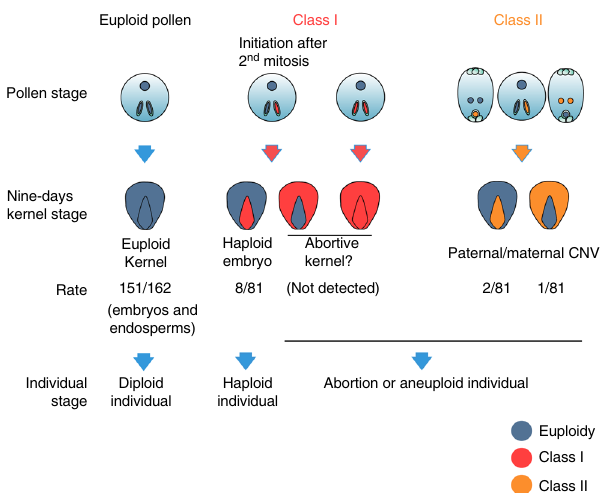
Fig. 5 A model for haploid generation. Two classes of aneuploid pollen grains were identi fi ed. In theory, both classes should carry one aneuploid sperm or two aneuploid sperm, and fertilize egg and/or polar nucleus. Class I pollen grains could induce haploid embryos, genome elimination endosperms, and kernels with approximately equal frequency. Class II pollen grains can fertilize egg and/or polar nucleus and may generate normal or abnormal kernels with a few chromosome fragments lost but not haploid kernels. The frequency of class I is higher than class II based on the present data. Eight haploids with paternal genome elimination were detected in 81 embryo samples. However, no paternal genome elimination was detected in 81 endosperm samples. It is possible that Class